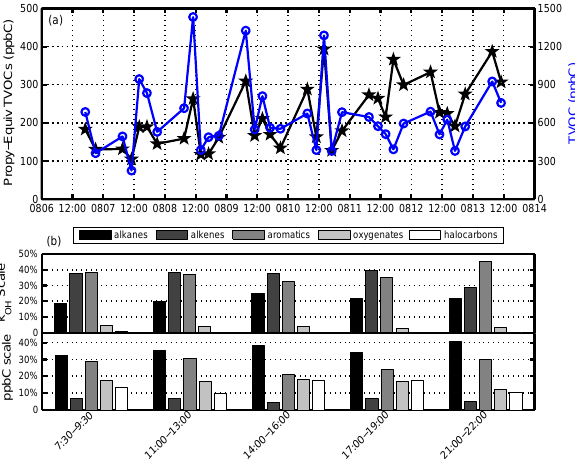
Fig. 3. (a) The time series of total VOCs expressed asppbC and Propy-EquivppbC, respectively; (b) Averaged VOC composition for five sampling periods based onppbC and k OH